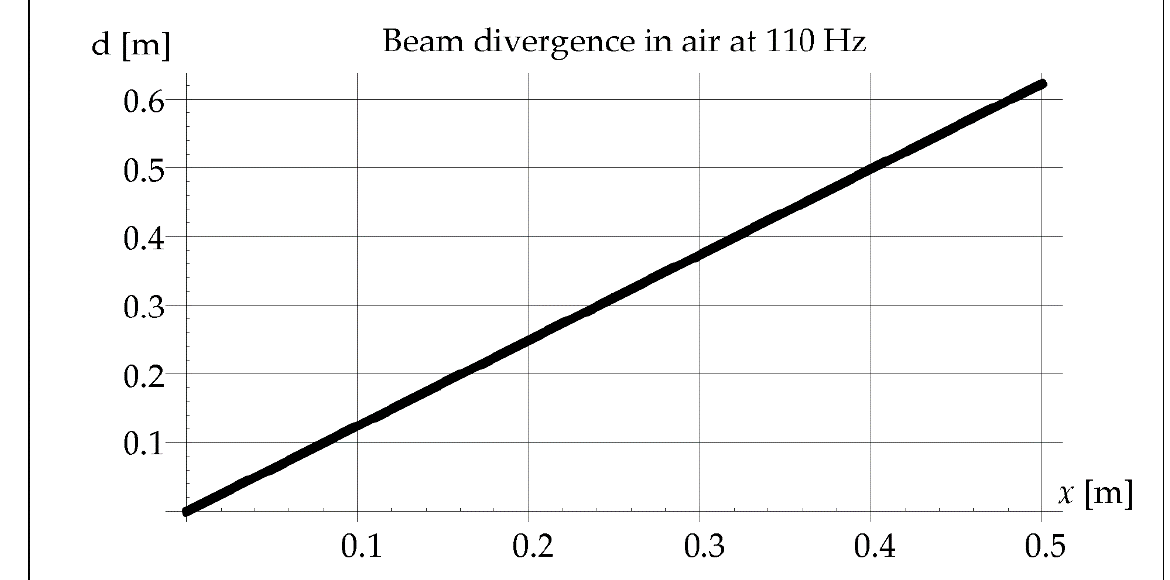
Figure 11. Beam divergence in air at 110 Hz. The vibration beam divergence determined in Formula (7) is 10 times greater in steel than in the air. It can be observed in Figure 12.